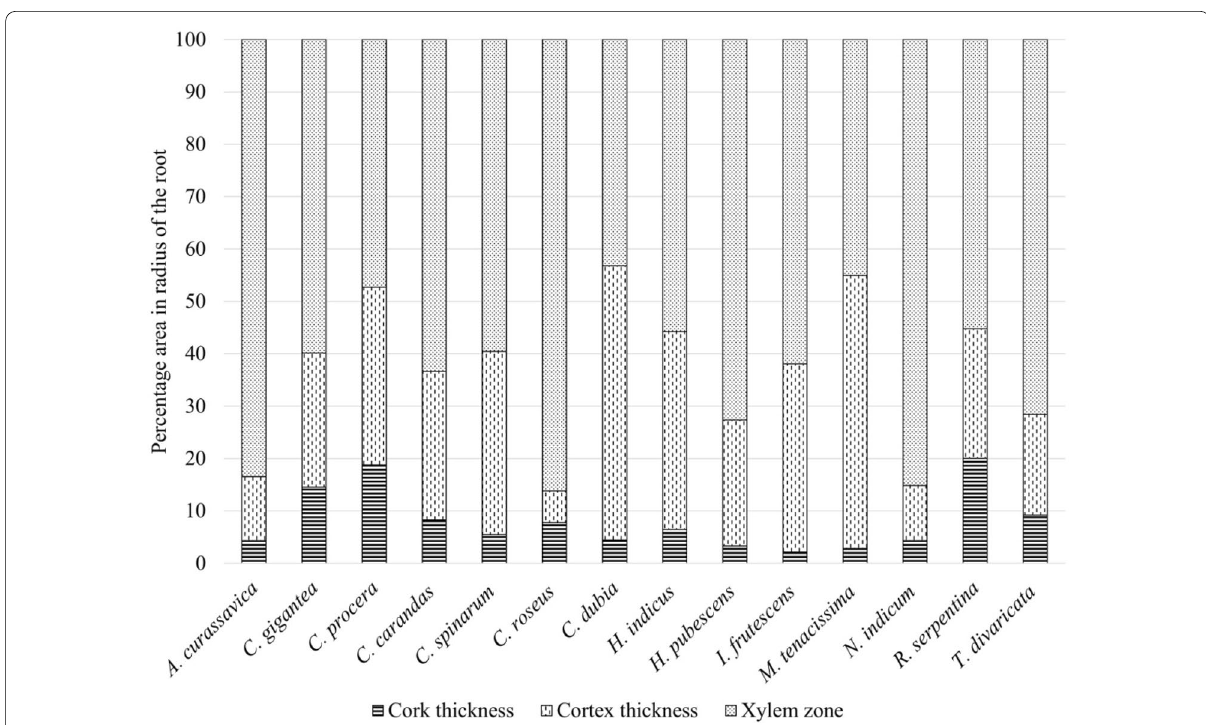
Fig. 3 Relative area of cork, cortex, and xylem zones based on the radius of the studied samples of the 14 species of family Apocynaceae used in